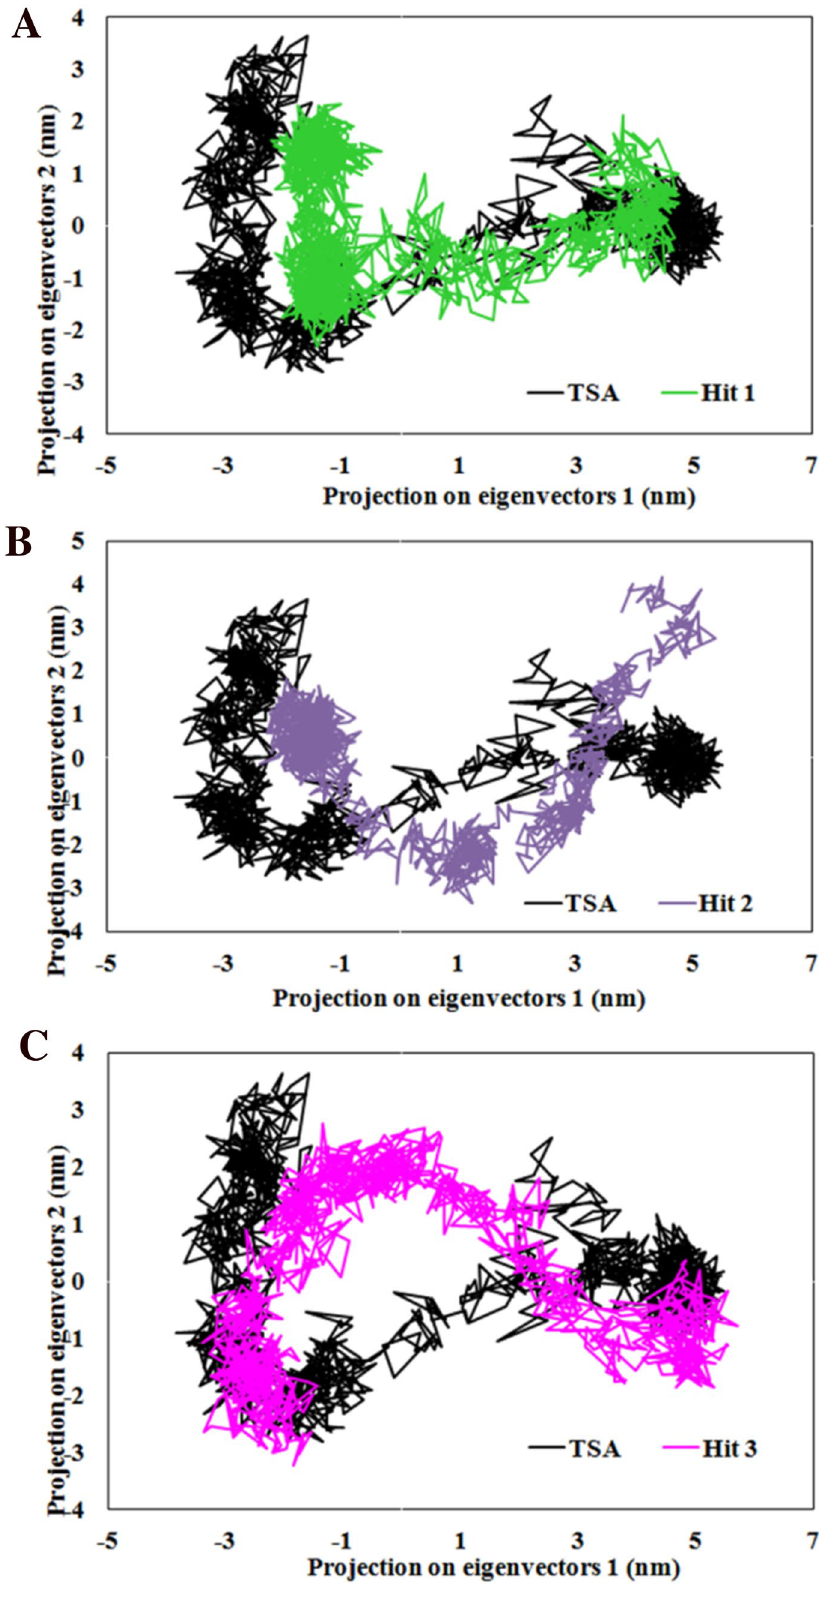
Figure 13. PCA plot showing most significant principal components of motion of the Cα atoms of HDAC3 in complex with ( A ) Hit 1/TSA, ( B ) Hit 2/TSA, and ( C ) Hit 3/TSA. The figure is drawn using Microsoft Excel 2013